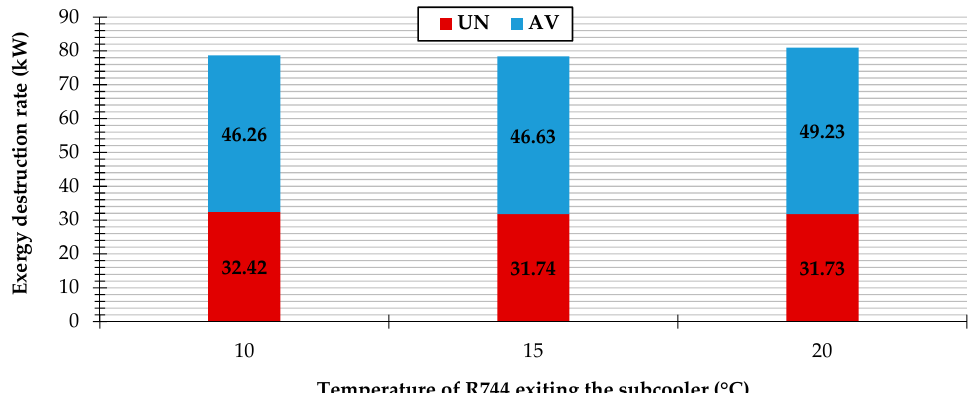
Figure 12. Effect of the temperature of R744 leaving the subcooler on the avoidable and unavoidable exergy destruction rates of the investigated system at the outdoor temperature of 40 °C.